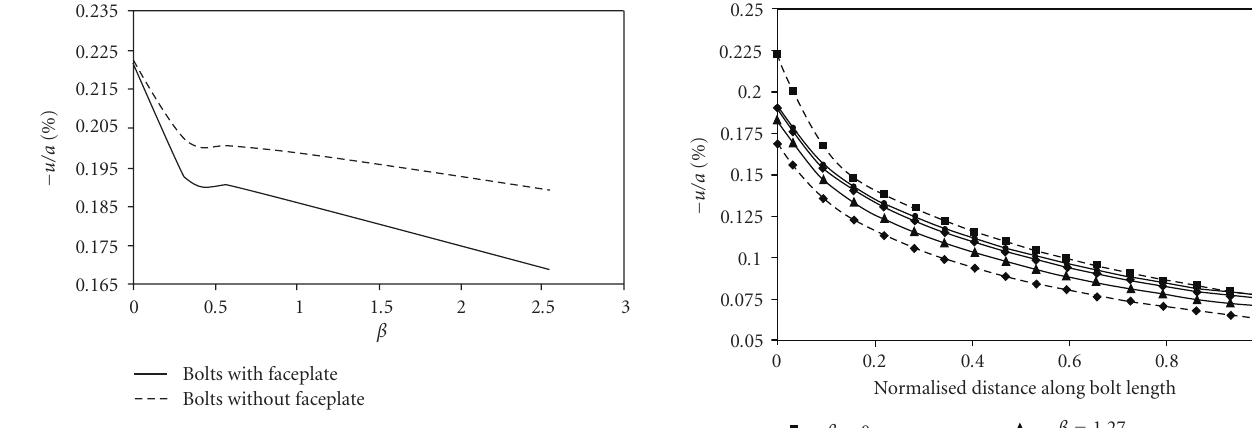
Figure 15: Variations in radial displacement in rock mass at tunnel boundary with bolts density.